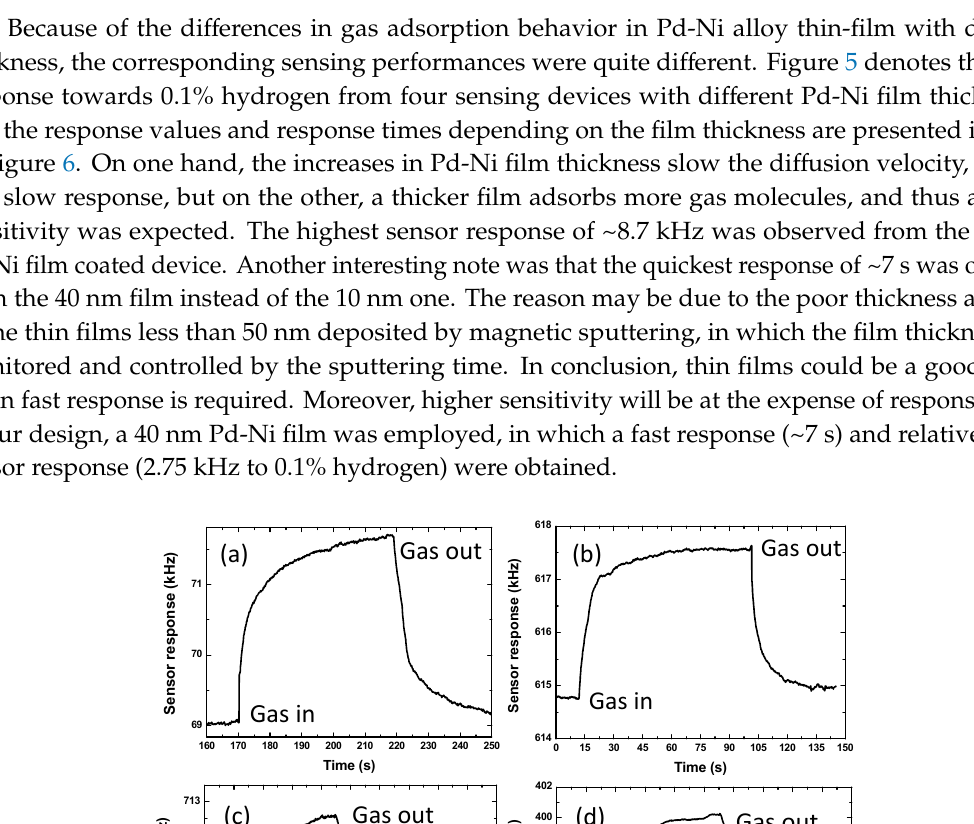
Figure 6. The relationship between the sensor response, response time, and the Pd-Ni thin-film thickness. 4.3. Sensitivity Evaluation The proposed 40 nm Pd-Ni alloy thin-film coated sensing device was exposed to different concentrations of hydrogen gas to evaluate its sensitivity. Figure 7 shows the sensor response towards various hydrogen gas concentrations (from 0.01% to 0.04%). With increases in hydrogen gas concentration, the sensor response amplitude increased accordingly. The sensor response values at various hydrogen gas concentrations are depicted in Figure 8, and the corresponding sensitivity was evaluated as 21.3 kHz/% (fitted by the least-squares method). As for another indicator, the detection limit can be obtained by theoretical prediction according to the relevant rules of IUPAC, that is, the detection limit is calculated as the lowest concentration of an analyte giving a sensor response of three times the baseline noise of the sensor itself. The observed sensor response from 0.01% hydrogen gas was ~270 Hz. Hence, a low detection limit of less than 0.001% is predicted because of the low baseline noise of ±5 Hz.